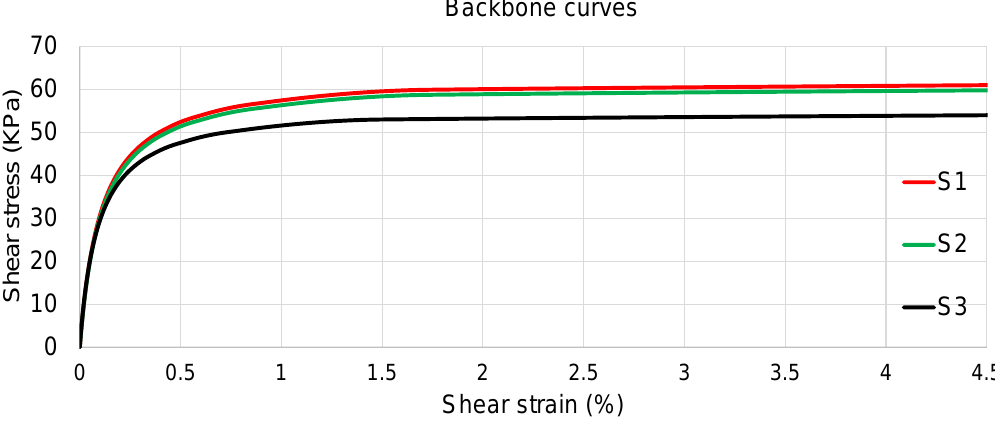
Figure 3. Backbone curves for soils S1, S2, and S3. Table 2. Characteristics of soils S1, S2, and S3.